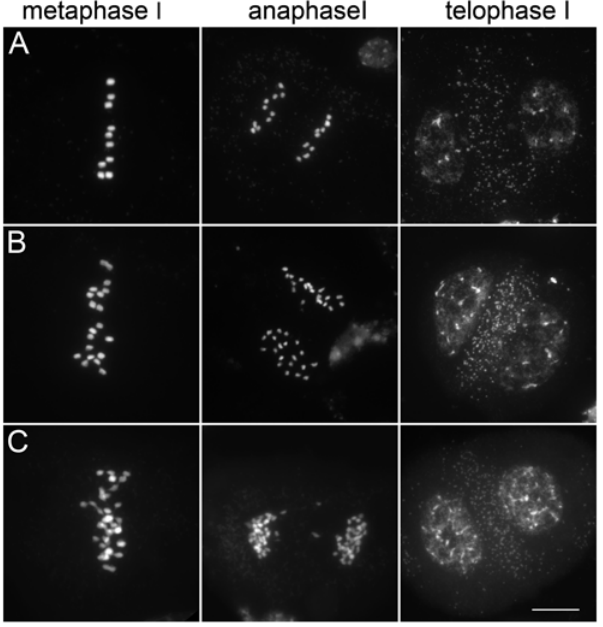
Figure 8. Male meiosis in 2n, 4n, and 8n MiMe plants. MiMe plants underwent a mitosis-like division instead of meiosis in 2n (A), 4n (B), and 8n (C) plants. Meiotic metaphase I, anaphase I, and telophase I are shown for each generation. Scale bar=10 m m.